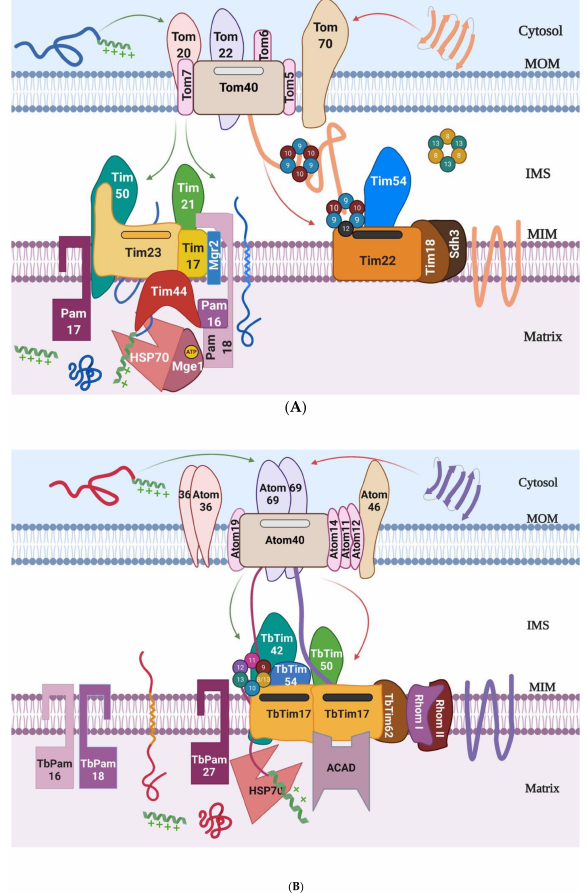
Figure 1. ( A ) The translocases of the mitochondrial outer and inner membranes, TOMs and TIMs, in Saccharomyces cerevisiae . TOM complex consists of Tom40, Tom70, Tom20, Tom22, Tom5, Tom6, and Tom7. The two TIM complexes are TIM23 and TIM22. The core components of the TIM23